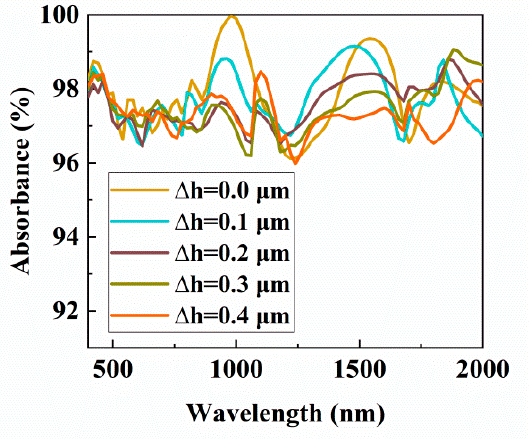
Figure 8. The measured absorbance curves of different height deviation values Δ h as a function of wavelength.